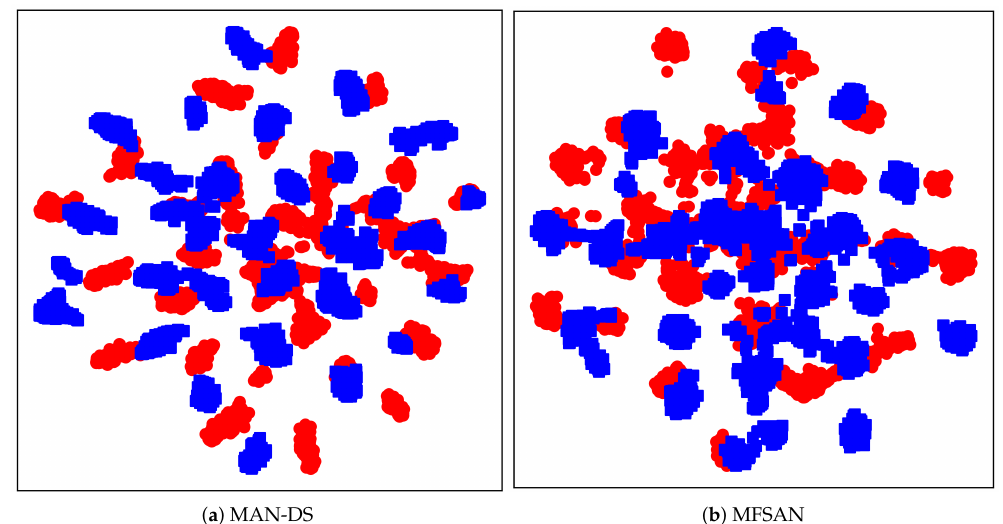
Figure 5. Domain-specific classifier feature visualization.